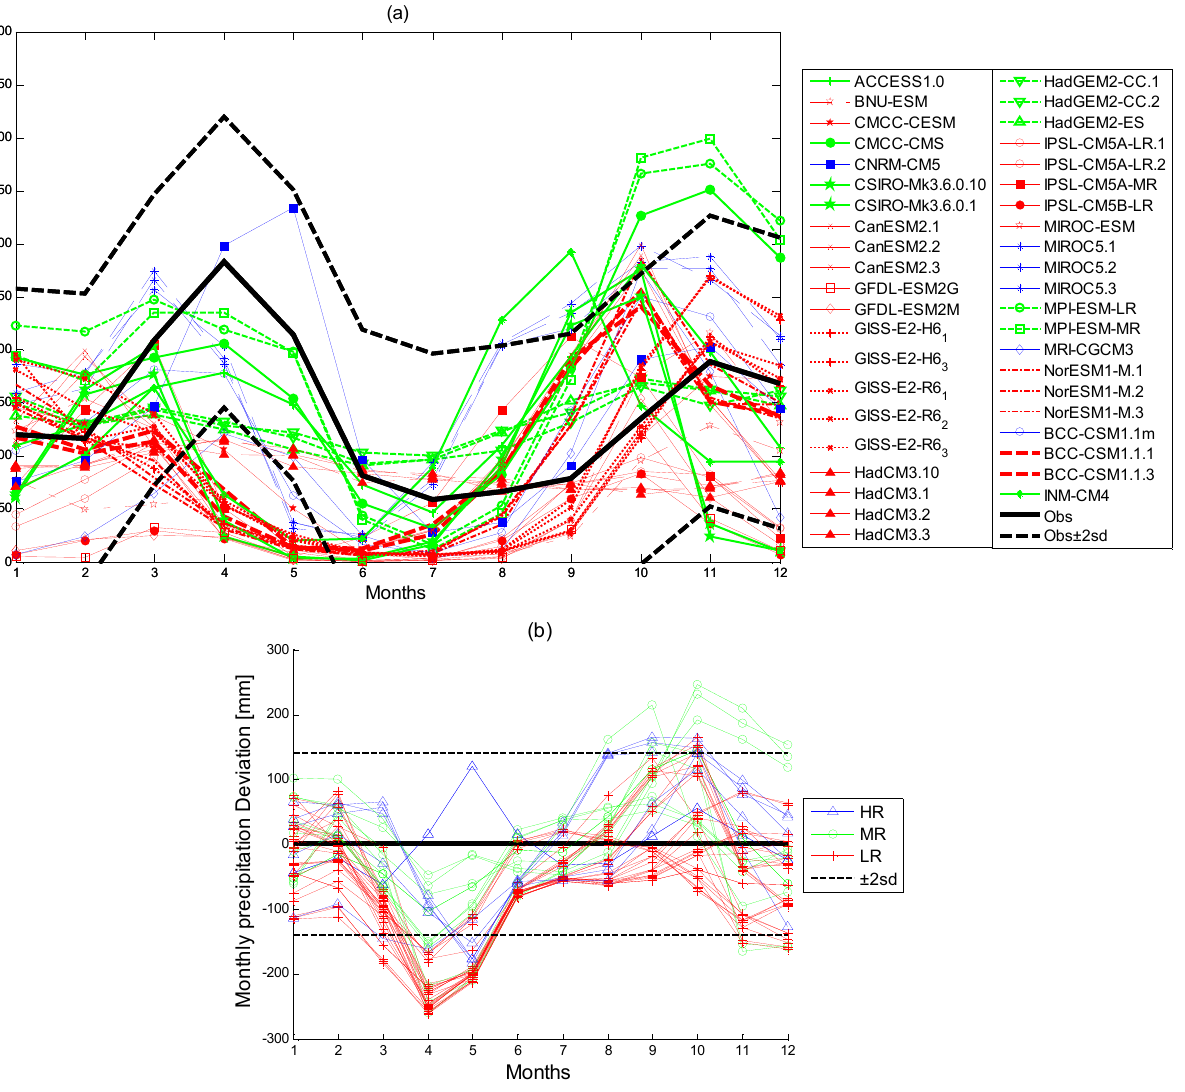
Figure 4. ( a ) Average monthly precipitation for the different GCMs compared to the observed series, red: Low resolution (LR) GCMs; blue: High resolution (HR) GCMs; green: Medium resolution (MR) GCMs; ( b ) Difference between modeled and observed precipitation for the different classifications of